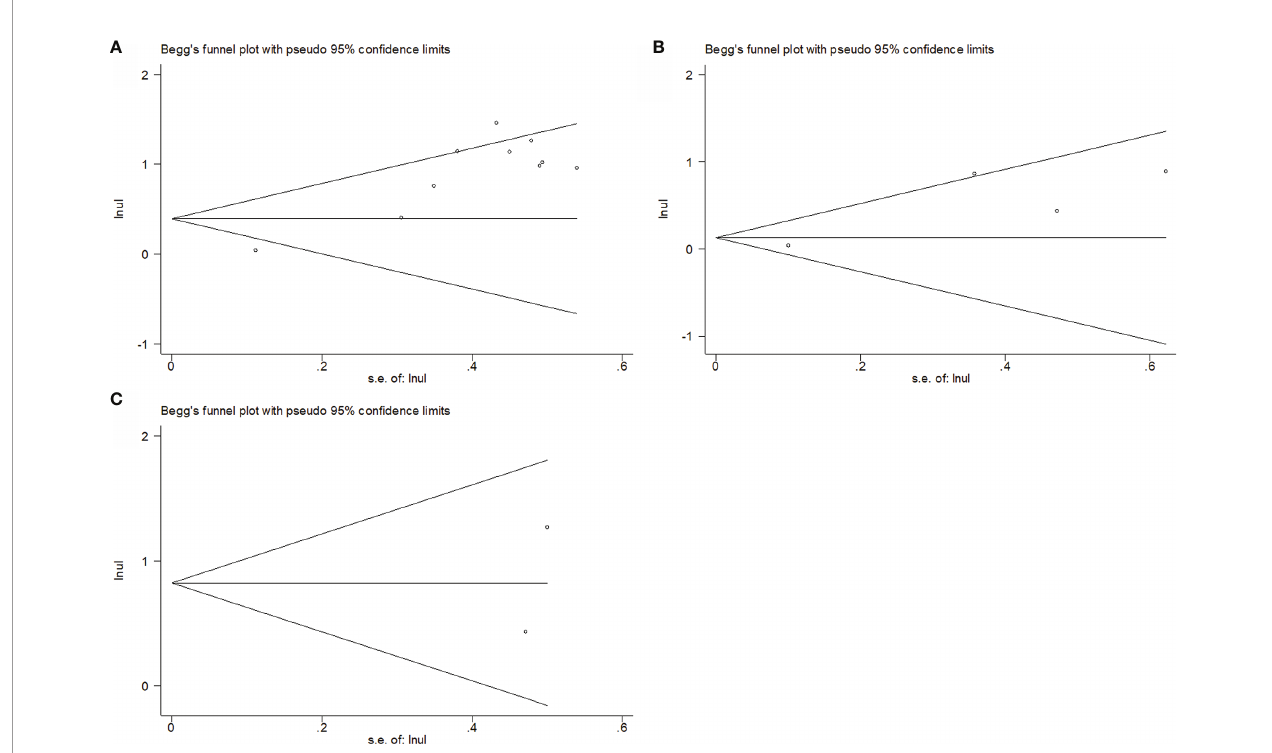
FIGURE 6 | Publication bias assessment using Begg funnel plot. (A) Begg ’ s test for OS; (B) Begg ’ s test for PFS/DFS; (C) Begg ’ s test for